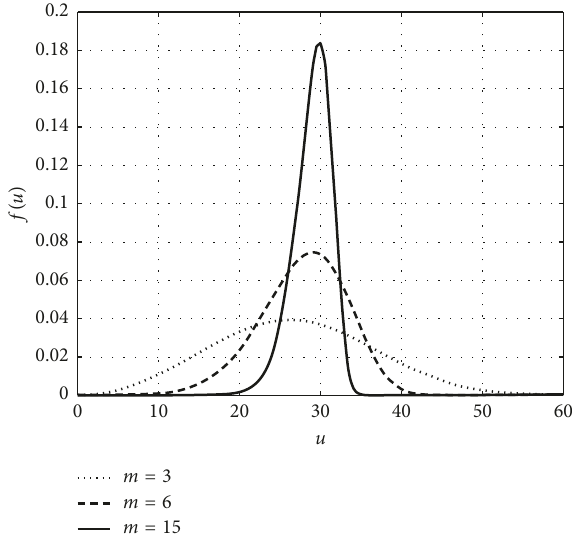
Figure 13: Probability density function for different degrees of homogeneity.